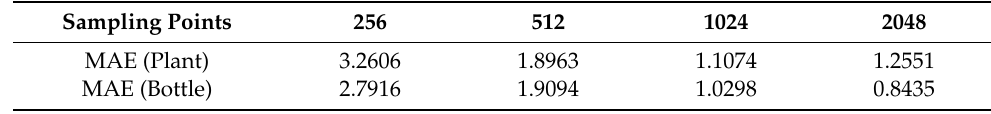
Table 3. Tests at different sampling degrees.